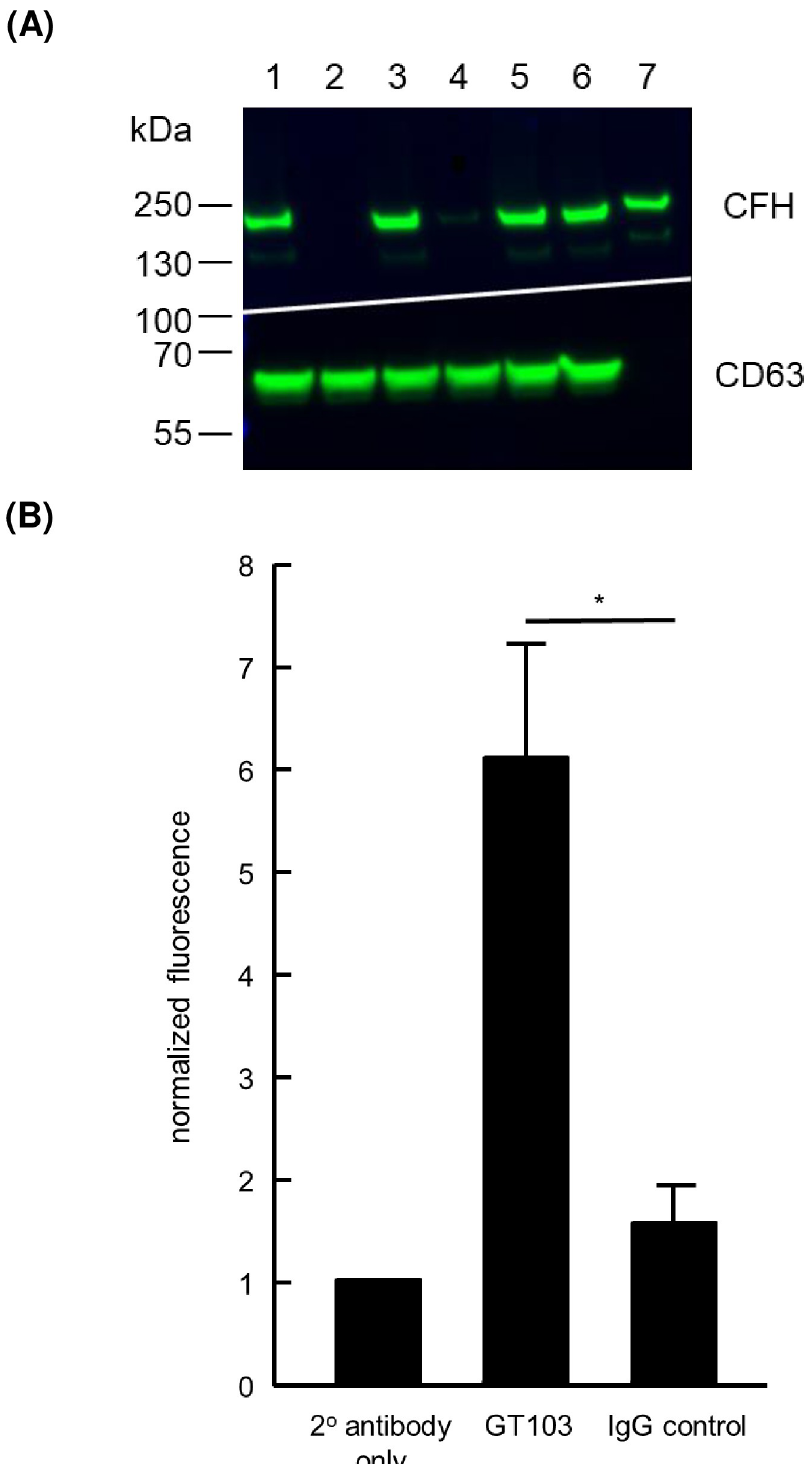
Fig 2. GT103 binding to CFH in tumor cell line-derived EV protein and to intact tumor cell EVs. Cell lines were cultured in exosome-free medium and EVs were isolated from conditioned medium with Total Exosome Isolation Reagent. (2A) Western blot of EV protein probed with GT103 and anti-CD63. 5 μ g EV protein was loaded per lane. The blot was probed with 0.5 μ g/ml GT103 and a secondary antibody-HRP conjugate, stripped, and reprobed with an